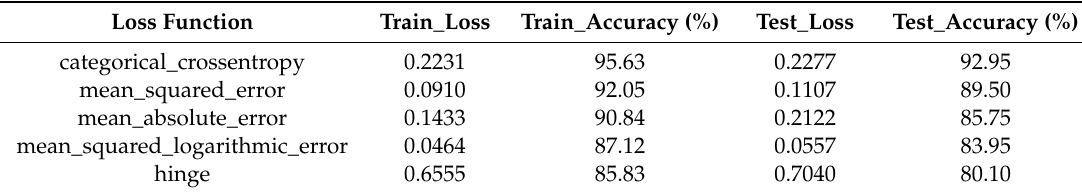
Table 2. The loss and accuracy results of di ff erent loss